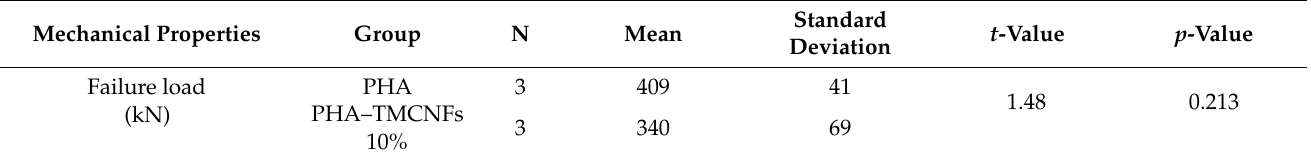
Figure 9. Viscoelastic properties of ( a ) PHA adhesive; ( b ) PHA–TMCNFs 10% adhesive; ( c ) Viscosity of adhesive; ( d ) Tan δ of adhesive. Table 3. Independent samples t -test of PHA and PHA–TMCNFs failure